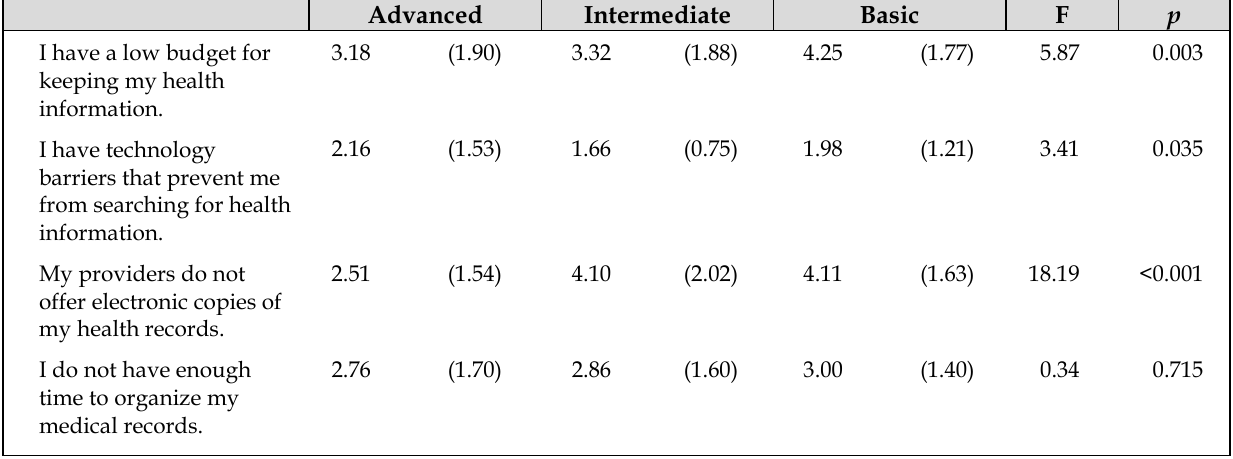
Table 3 Health information sources and barriers